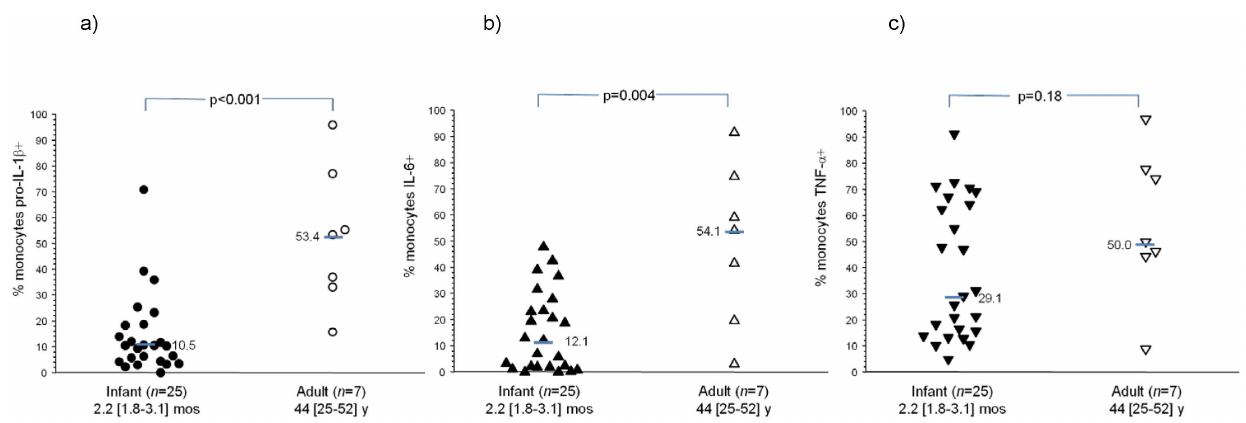
Figure 1. Intracellular cytokine staining in R-848 (1 m M) stimulated monocytes for (a) pro-interleukin (IL)-1 b , (b) IL-6, and (c) tumor necrosis factor (TNF)- a . Unstimulated condition is subtracted from each value. Bars are median values. Ages are shown as median [95% confidence